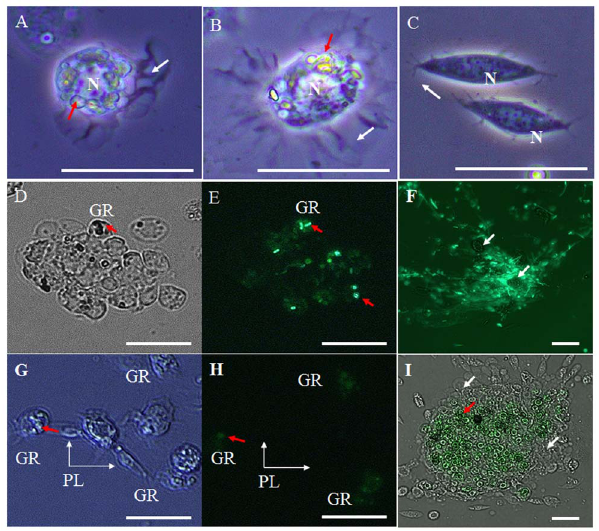
Figure 2. Images of immunologically activated granulocytes and encapsulation. (A and B) granulocytes changed their shape rapidly and generated large lobopodia-like, fan-like, or amoeba-like structures (indicated by white arrow). The highly polymorphic glittering vacuoles of variable size and round or irregular shape were closely packed in the granulocyte cytoplasm (indicated by red arrow). Although several filopodia were also generated in the plasmatocytes (C; indicated by white arrow), they did not undergo any sudden or rapid changes in shape and had no polymorphic vacuoles in their cytoplasm. With the exception of most granulocytes and some plasmatocytes, the other cell types showed no morphological changes compared to naı¨ve larvae hemocytes (data not shown). (D and E) The granulocytes phagocytosed and engulfed GFP-expressing E . coli at 4 h post infection (GFP- expressing E . coli are indicated by red arrows). (G and H) Phagocytosis of GFP-expressing S . cerevisiae (indicated by red arrow) by GRs (indicated by short white arrow). Encapsulation by granulocytes at 12 h post bacterial (panel F; GFP-expressing E . coli phagocytosed by granulocytes are indicated by white arrows) and yeast infection (panel I; GFP-expressing S . cerevisiae are indicated by red arrow, and granulo- cytes are indicated by white arrow). GR, granulocytes; PL, plasmato- cytes. N, nuclei, Scale bar=20 m m.